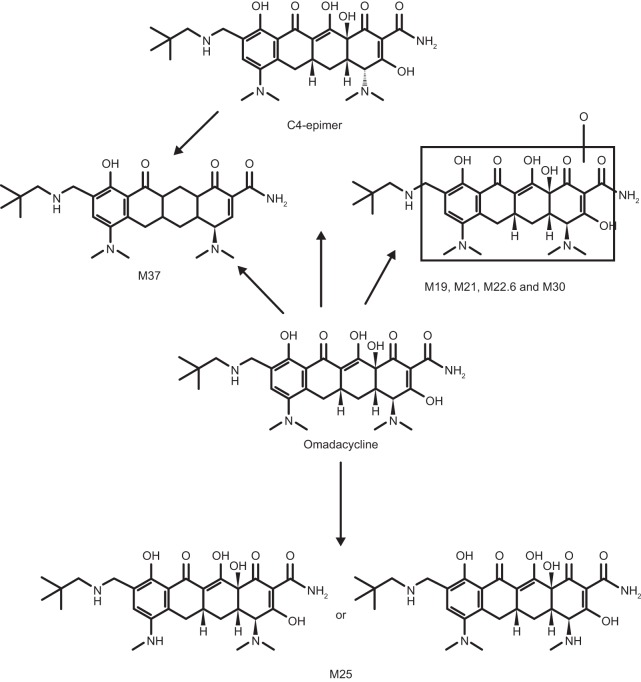
Proposed metabolic scheme of 14C-omadacycline in the HW rats.